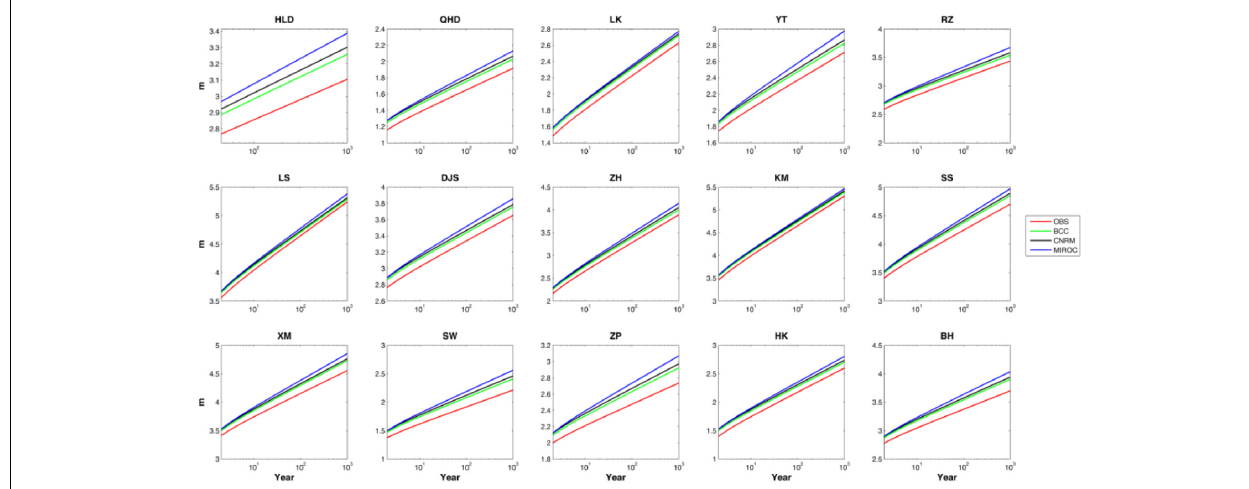
FIGURE 7 | Return levels of the extreme sea level at present (blue line), return levels of the extreme sea level under the 2.0 ◦ C temperature rise scenarios [BCC-CSMI-1(black line), CNRM-CM5(red line), MIROC-ESM-CHEM(green